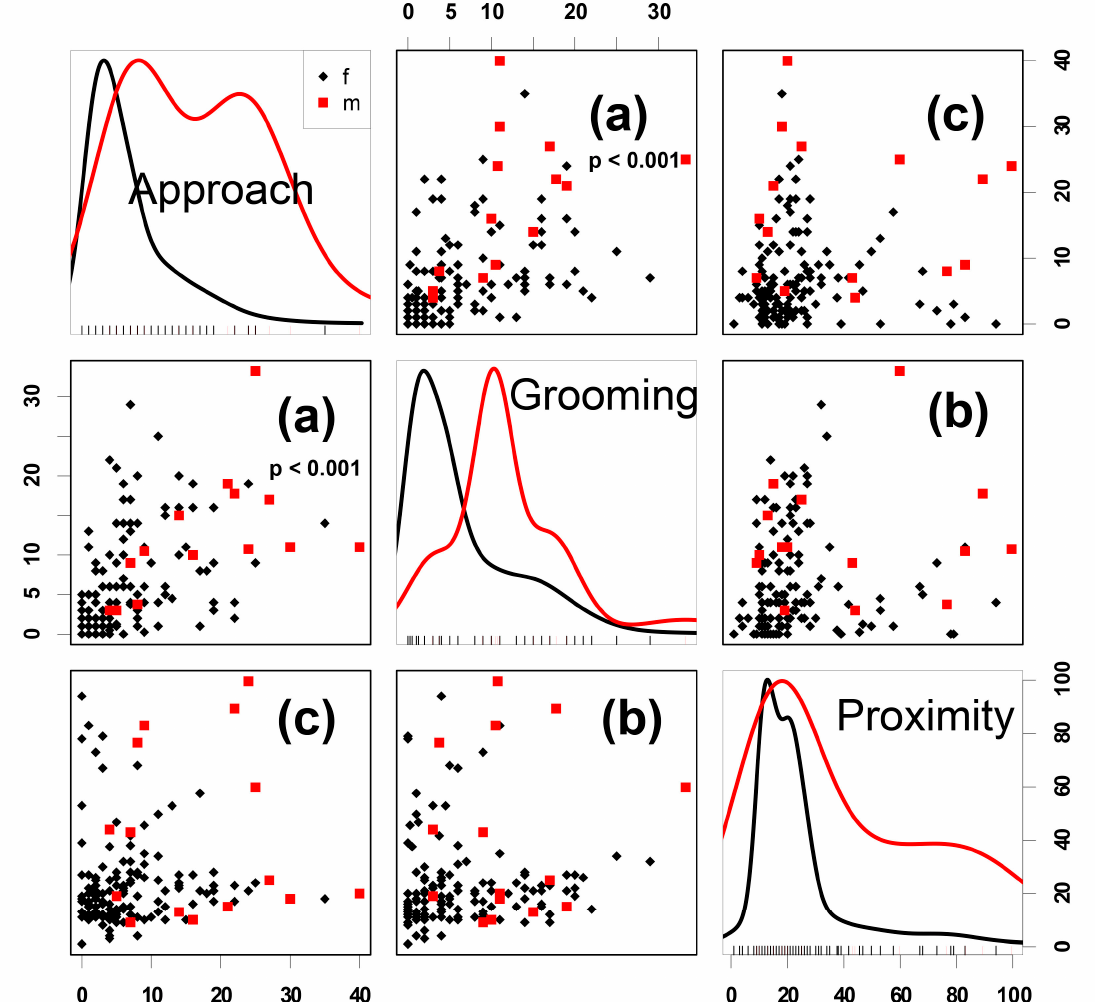
Figure 2. Correlations between the frequencies of grooming, friendly approaches, and being in spatial proximity of pairs of horses in each group. On the diagonal frequencies of the behaviours approaches, grooming and proximity are shown for male (red) and female horses (black). The scatterplots depict the correlations between the frequencies of pairs of parameters. The y and x axes quantify the frequencies of the parameters in the respective column (x-axis) or row (y-axis). The frequency of pairwise ( a ) grooming and friendly approaches correlate strongly, i.e., when the frequency of grooming increased, friendly approaches also increased. ( b ) grooming and proximity and ( c ) approach and proximity did not correlate, i.e., when animals stayed in close proximity some showed a low and others a high grooming and friendly approach frequency. Significant correlations are given with p < 0.001.